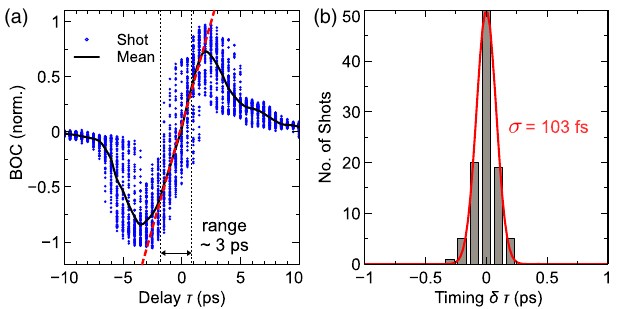
FIG. 2. Jitter determination by balanced optical cross- correlation. (a) Measured BOC curve by varying the FEL – table- top laser pulse delay τ for an average of 100 FEL macropulses (blue points) per delay step. The linear region (red line) of the averaged function (black line) represents the dynamic range of the tool (about 3 ps). Analyzing the delay values at BOC zero- crossing, the timing statistics shown in the histogram plot in (b) is obtained. By fitting a Gaussian distribution, a jitter value of σ ∼ 100 fs is extracted.